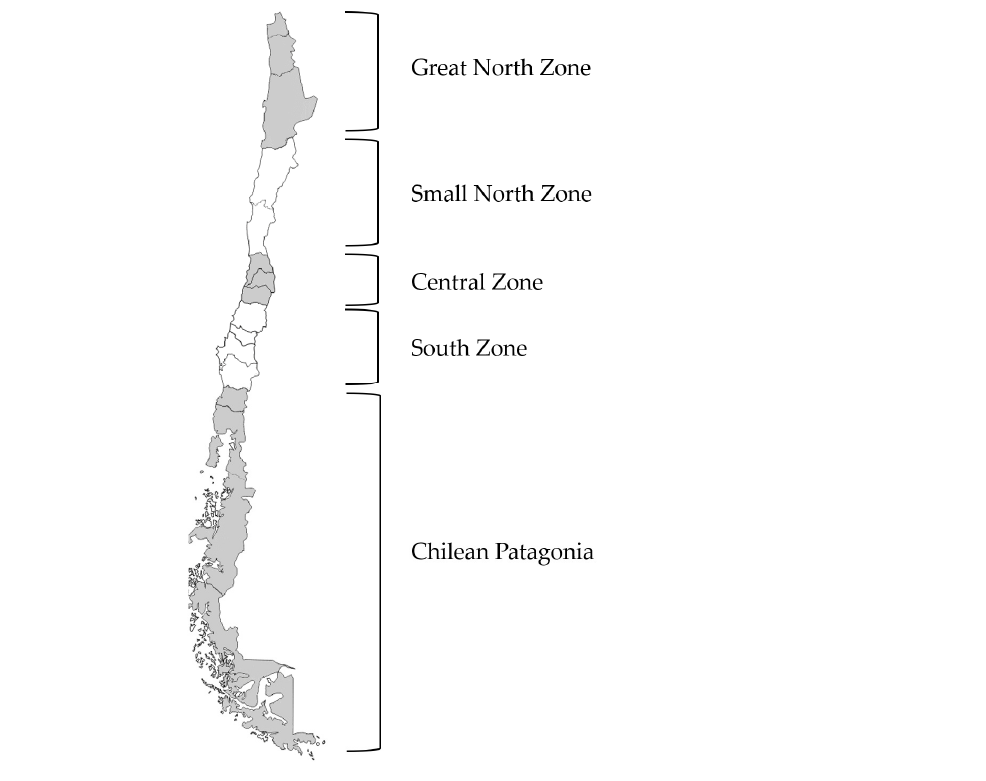
Figure 2. Map of Chile. Table 1 provides a summary of the agricultural characteristics of the five zones. Table 1. Main agrarian characteristic of